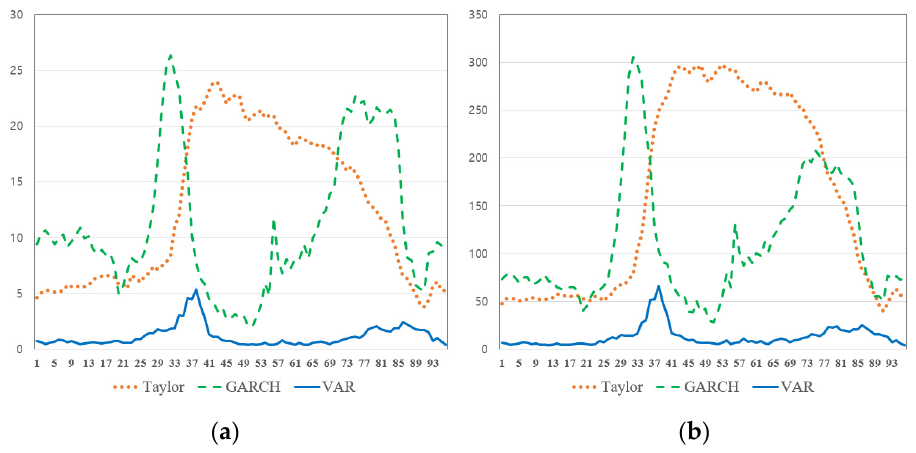
Figure 5. Forecast (k = 1) performance evaluations categorized by quarter-hour for models in terms of ( a ) MAPE and ( b ) RMSE.